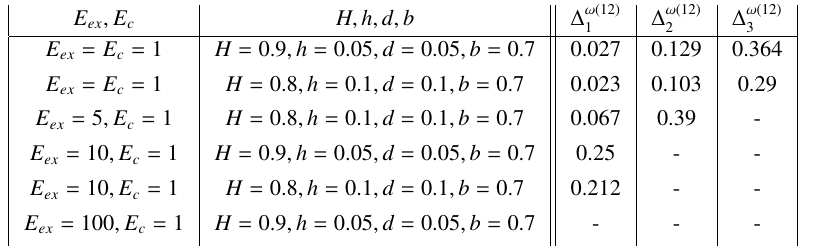
Table 4. Relative di ff erences for non-homogeneous I-beam, ν = 0 . 25 ,ε = 1 / 15 E ex , E c H , h , d , b ∆ ω (12) 1 H = 0 . 9 , h = 0 . 05 , d = 0 . 05 , b = 0 . 7